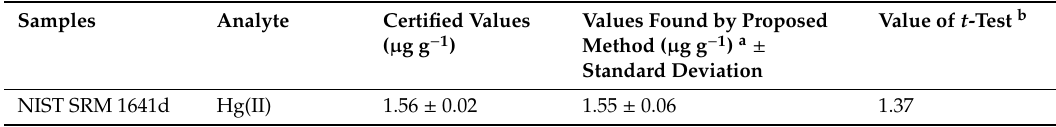
Table 3. Analytical method validation by analyzing standard reference material (SRM) after column